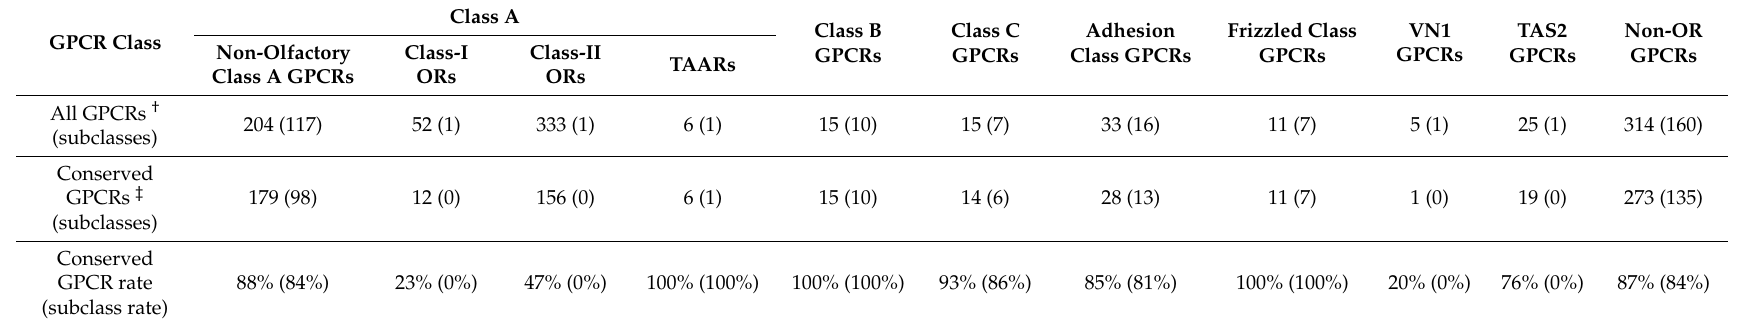
Table 1. Rate of human GPCRs with conserved helix-8-second residue in agonist–G protein pair-based